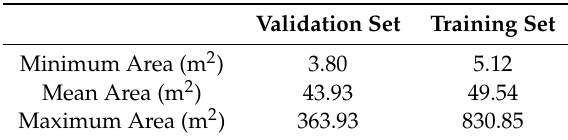
Table 2. Minimum, mean, and maximum area values for tree crowns within the validation and training